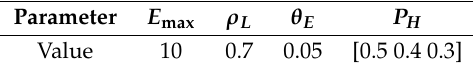
Table 2. Default Parameter